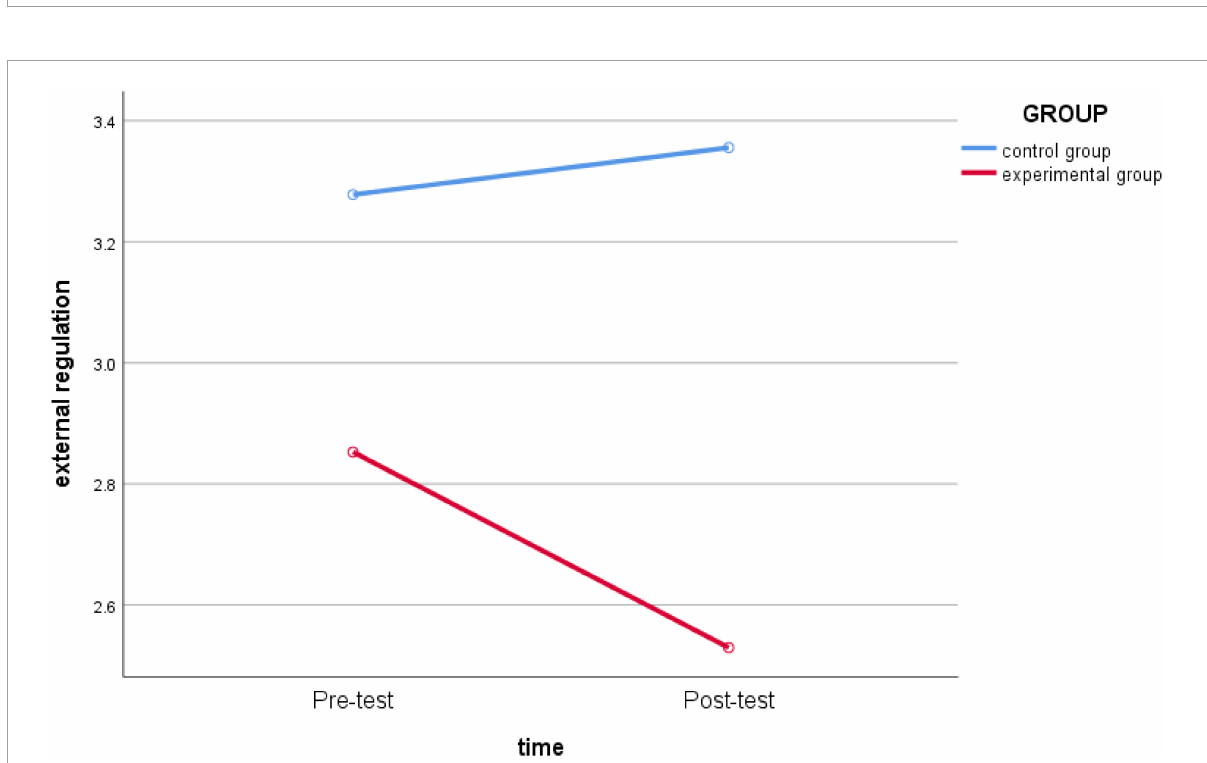
FIGURE3 Schematic diagram of the changes in external regulation between the experimental group and the control group before and after